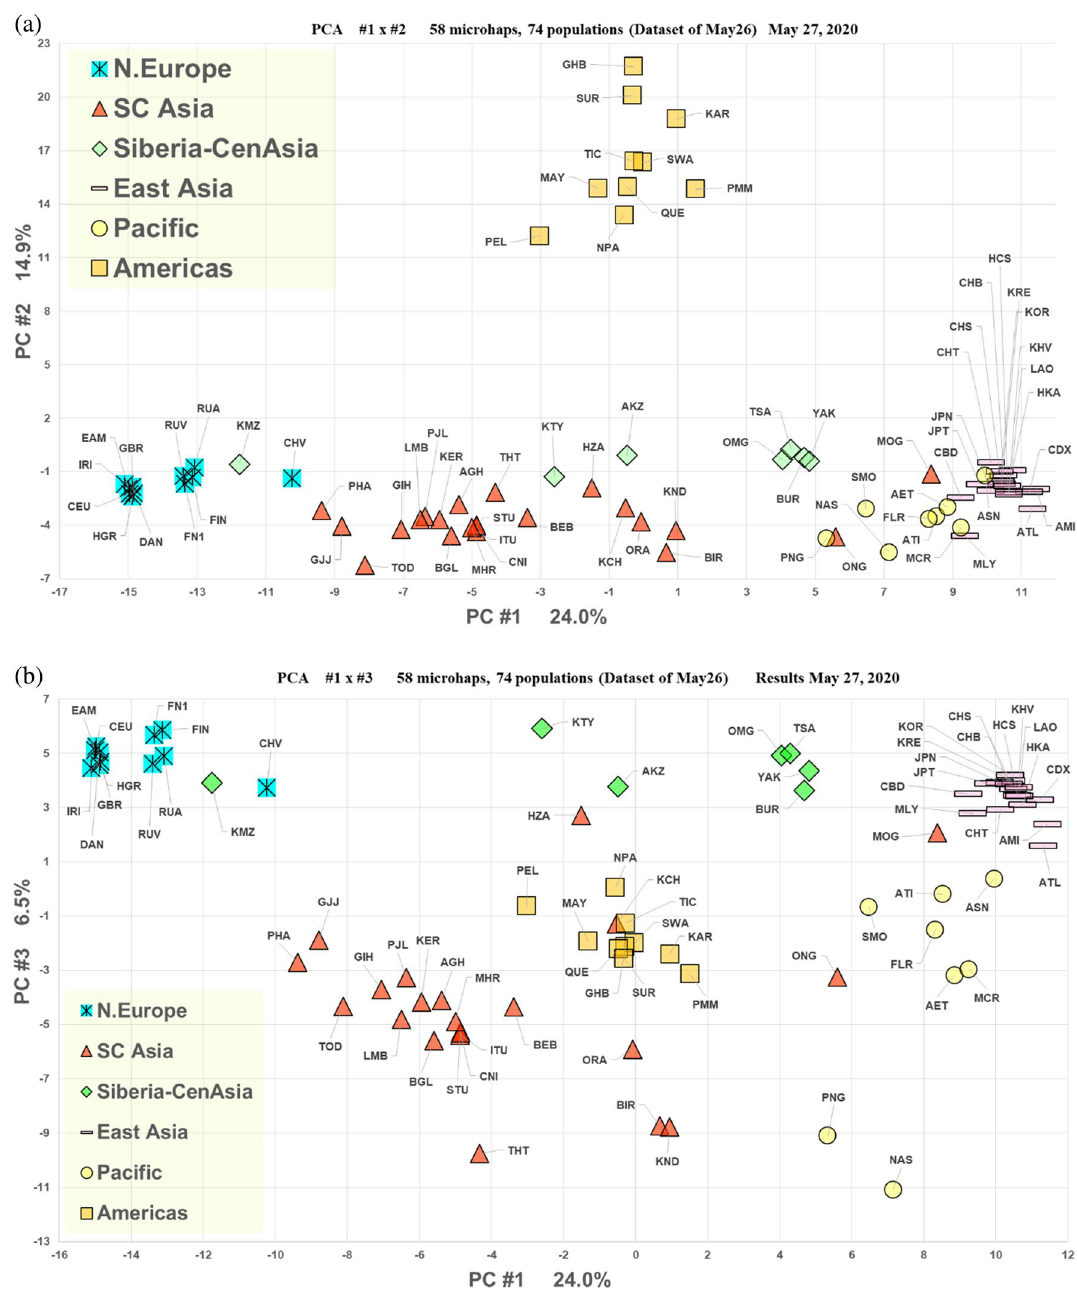
Figure 5. PCA results for 74 populations. ( a ) PC1 by PC2. ( b ) PC1 by